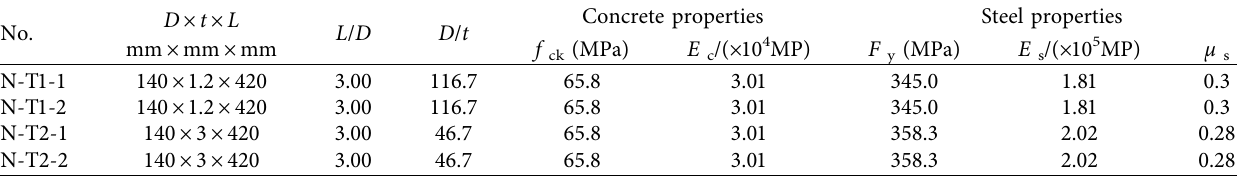
Table 1: Geometric and material properties of specimens.